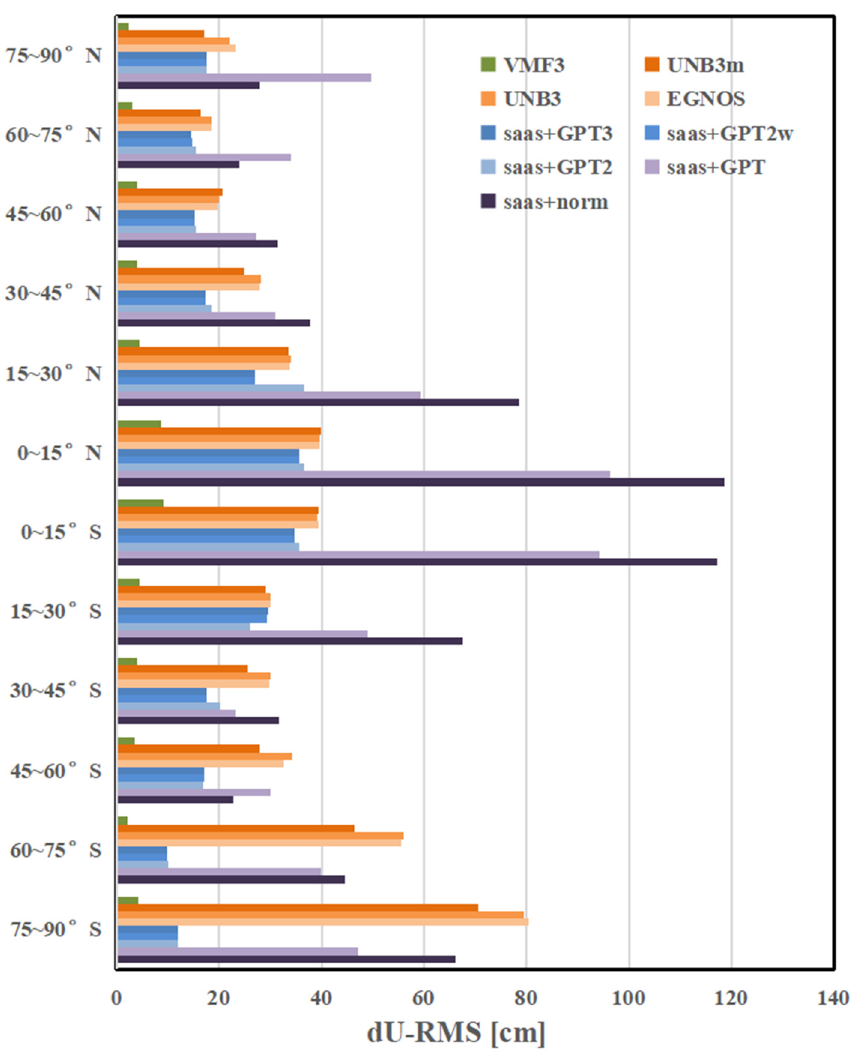
Figure 10. RMSs of the vertical SPP biases caused by dZTDs from the 9 models (saas+norm/GPT/GPT2/GPT2w/GPT3, EGNOS, UNB3, UNB3m, VMF3) at different latitude re- gions (unit: cm).